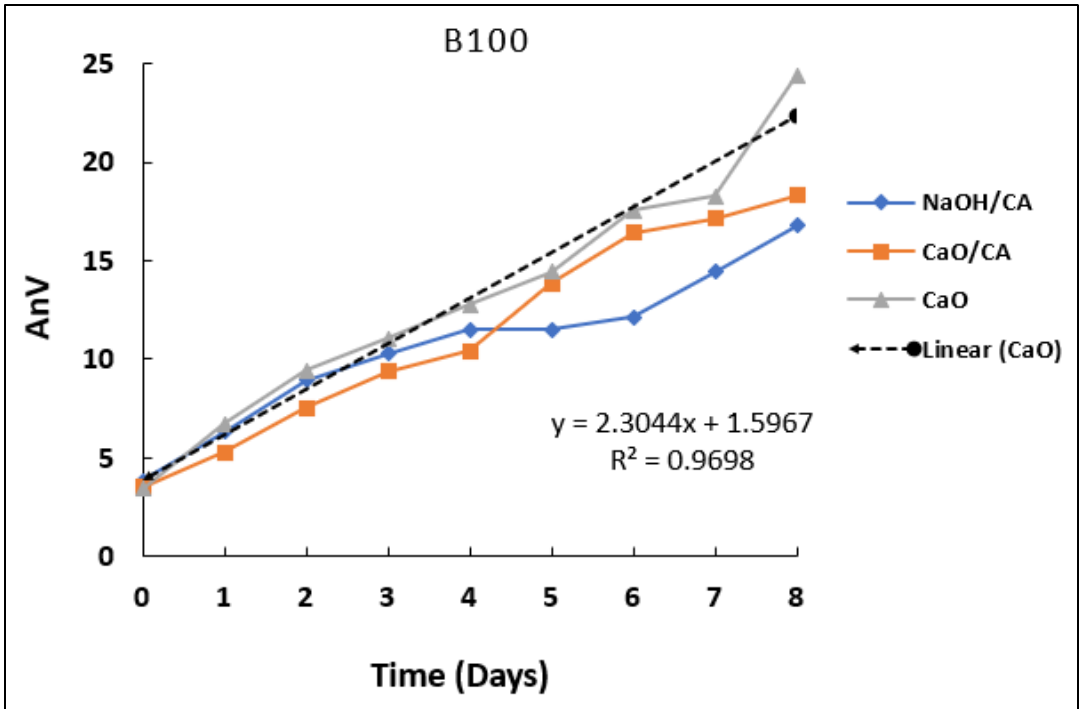
Figure 5. p -Anisidine values of biodiesel and biodiesel/diesel blends under accelerated storage. The R 2 value applies to the curve of the CaO catalyst.